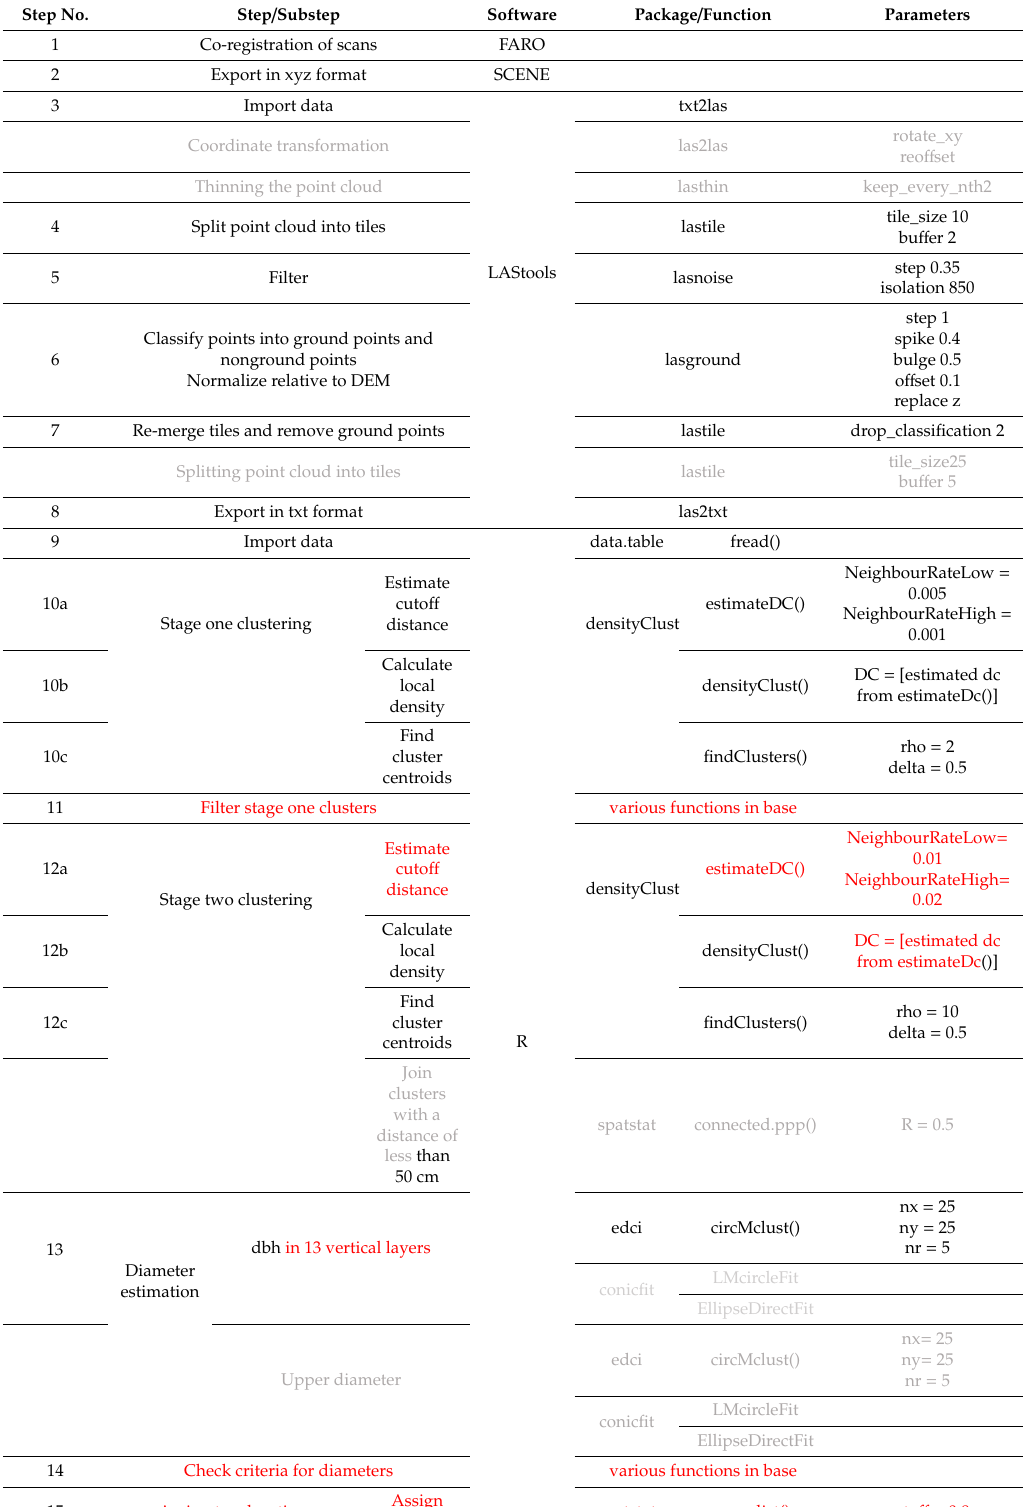
Table A2. Workflow and applied software functions and parameters. Compared with Ritter et al. [7], the red steps indicate the additional steps and the gray steps indicate the omitted steps. DEM, digital elevation